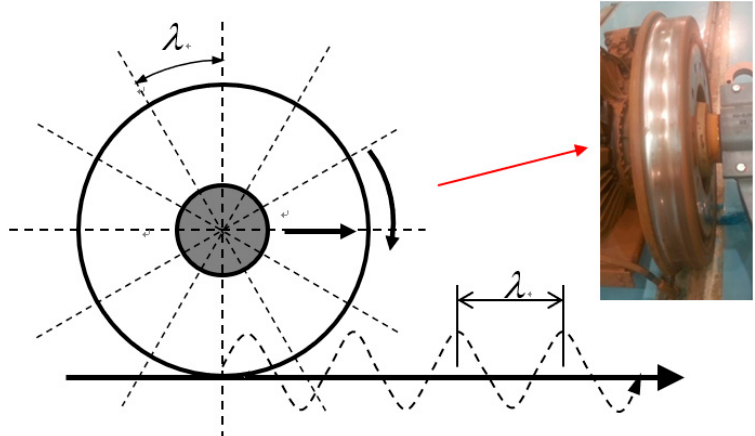
Figure 16. Description of basic condition for wheel OOR generation [12].